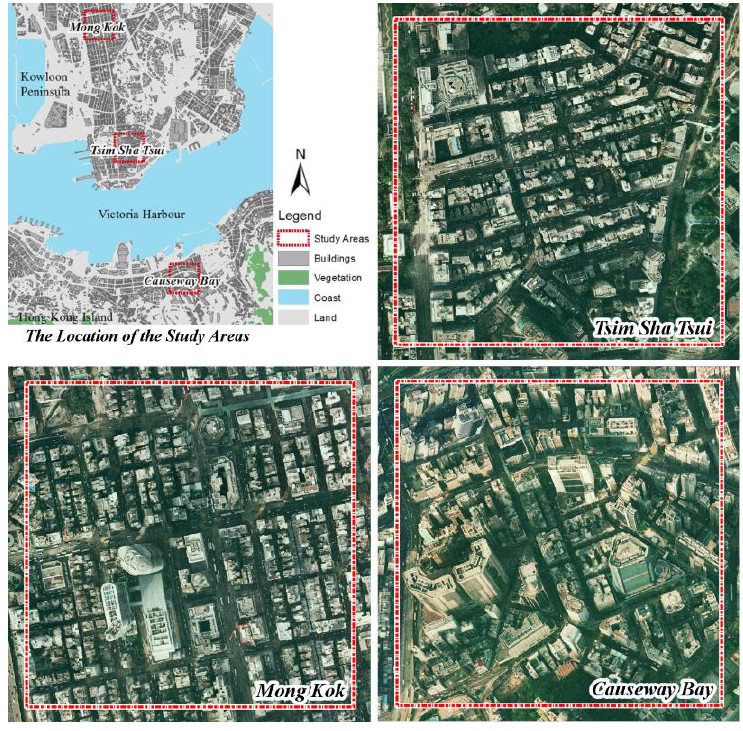
Figure 1. The location and the building morphology of the three study areas (the size of the red rectangle is 500 × 500 m).